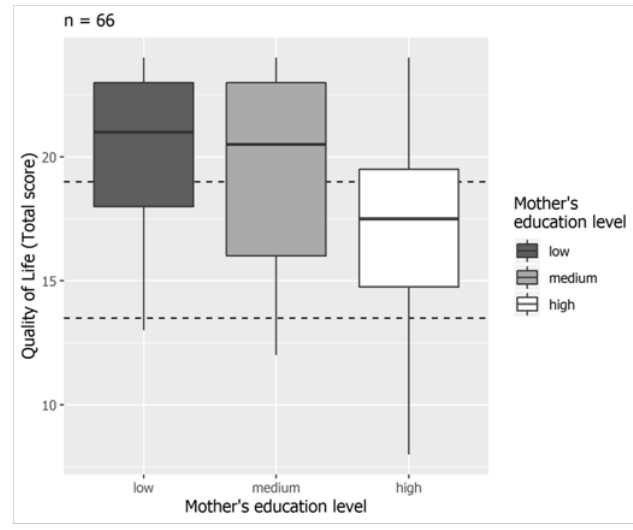
Figure 1. Health-related quality of life and education level of mothers .